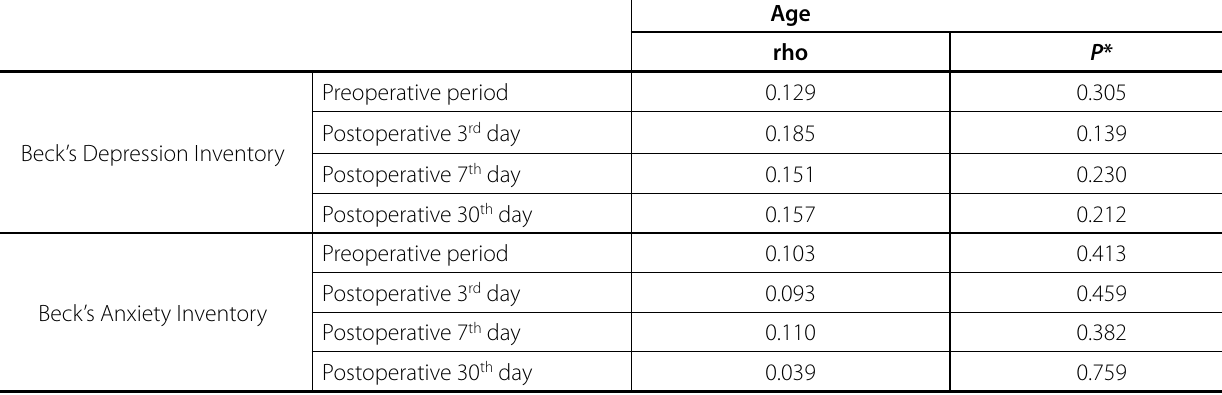
Table 5 . Statistical correlation between age and Beck’s depression and Beck’s anxiety test values (no significant value; P >0.05).